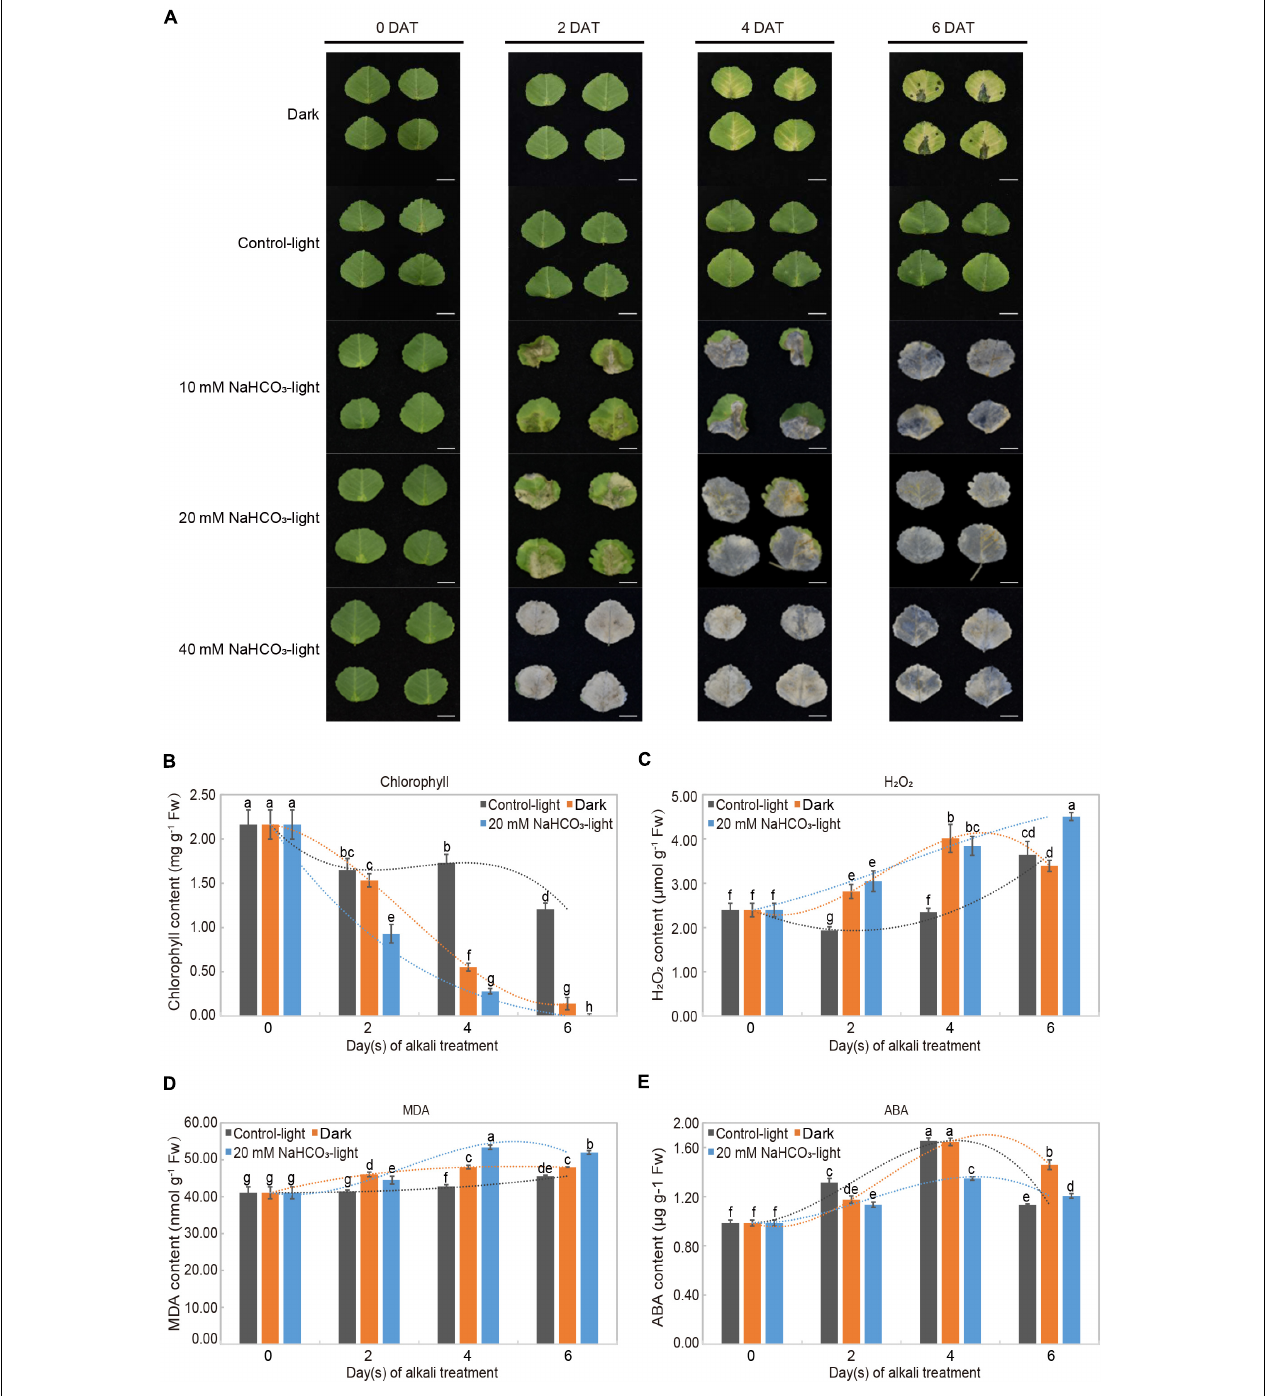
FIGURE 1 | Alkali stress-induced leaf senescence and physiological analysis in Medicago truncatula . (A) Leaf senescence progression and color change of detached M . truncatula leaves under dark (Dark), normal light (Control-light), and 10, 20, 40 mM NaHCO 3 (10 mM NaHCO 3 -light, 20 mM NaHCO 3 -light and 40 mM NaHCO 3 -light) conditions for 0, 2, 4, and 6 days. DAT: days after treatment. Scale bar = 1 cm. (B) Chlorophyll (a + b), (C) H 2 O 2 , (D) malondialdehyde (MDA), and (E) abscisic acid (ABA) in detached M . truncatula leaves exposed to different conditions during senescence. Values are presented as mean ± SE of three independent biological replicates per time point. Different letters indicate significant differences among treatments according to the analysis of variance (ANOVA, P < 0.05). Error bars correspond to standard error. FW, fresh weight.